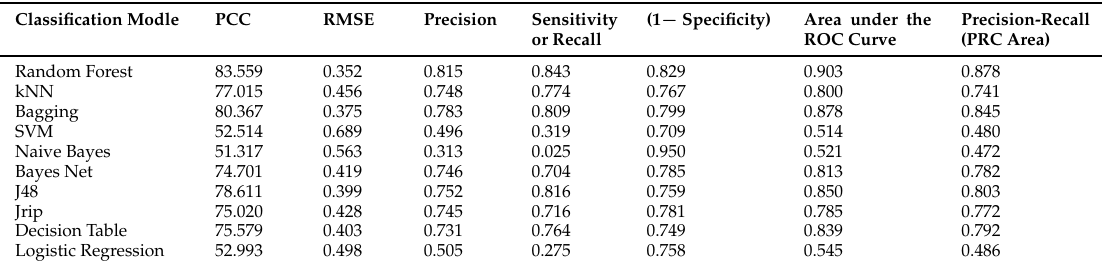
Figure 5. Random Forest algorithm outperforms all groups and demonstrated (AUC = 0.903 when fold = 60). Table 8. Evaluation measures of binary classifiers: assessment of a classifier’s prediction performance where k-fold = 60 (Train 90% : Test